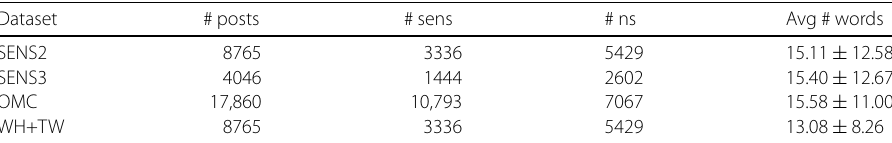
Table 4 Details on the datasets